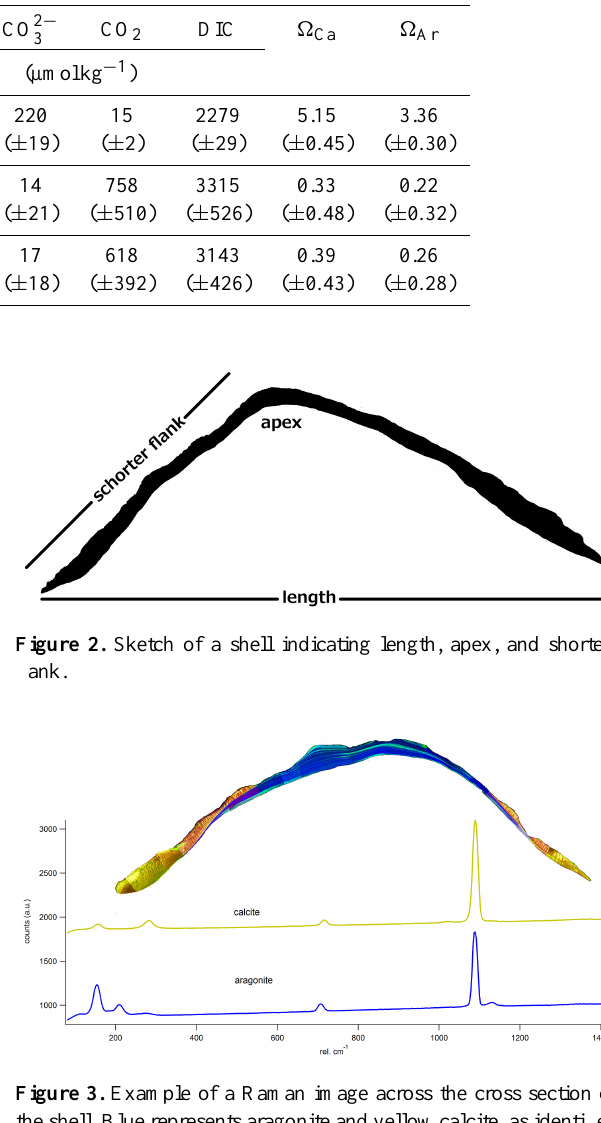
Table 1. Mean value ( ± SD) of temperature ( T ), pH T (total scale), p CO 2 , concentration of HCO − sea water, dissolved inorganic carbon (DIC), saturation state ( (cid:127) ) of aragonite and calcite for the study sites.